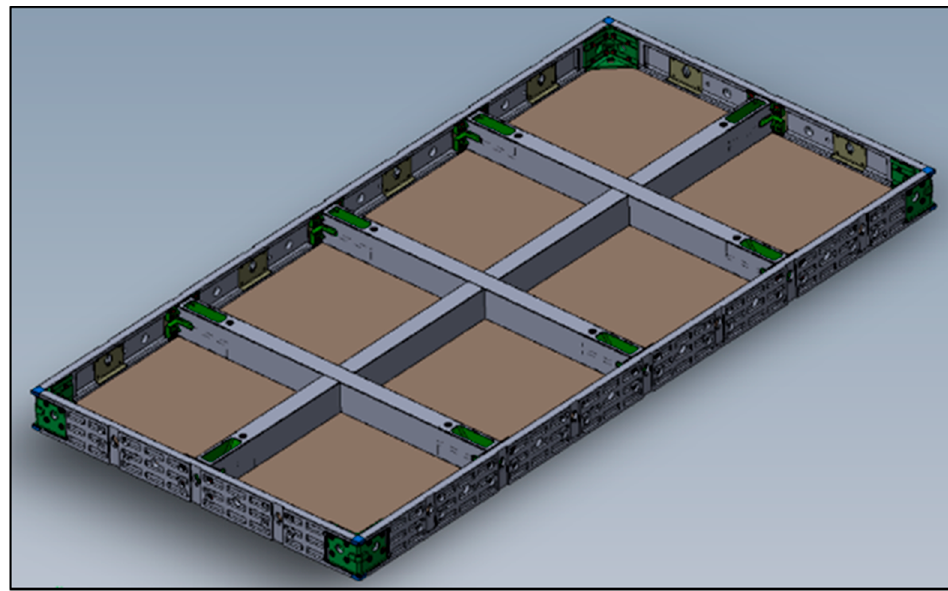
Figure 7. Three-dimensional model of the CSF.